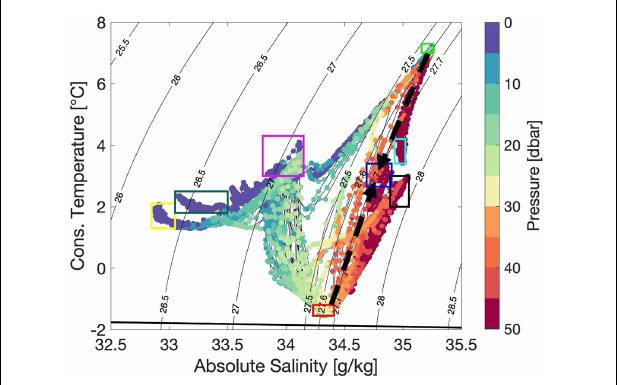
FIGURE 3 | Temperature-salinity-properties along the AUV-transect. Colors indicate the pressure (dbar) of the individual measurements. Black contour lines indicate potential density (reference 0 dbar). Colored boxes indicate different water masses (green – Atlantic Water, red – Polar Water, yellow, green and magenta – different types of surface waters, black and cyan – different types of colder and slightly fresher Atlantic Water, blue – mixed water originating from cabbeling. Mixing occurred along the 27.6 isopycnal indicated by the two black arrows. Same colored-boxes are used to indicate the location of these water masses along the section in Figures 2 , 4 . The thick black line indicates the freezing point